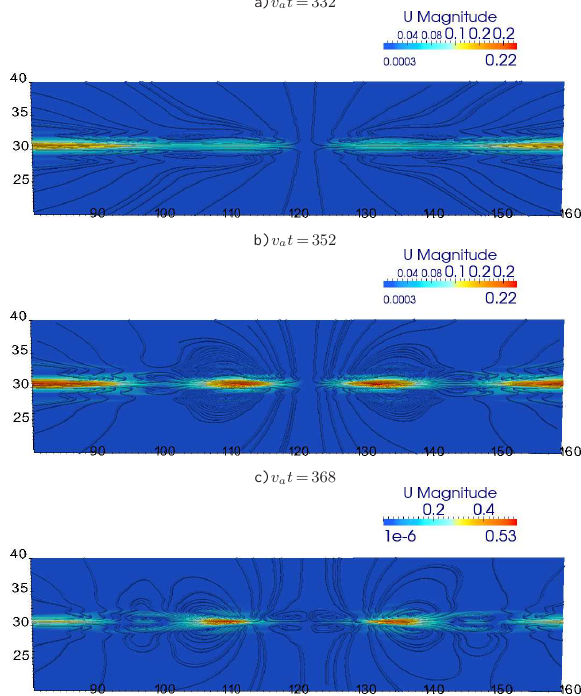
Fig. 6. Later evolution (xz plane). The flow lines are shown super- Fig.6. Later evolution ( x − z plane). The flow lines are shown superimposed over a false colour representation imposed over a false colour representation of the flow speed. The of the flow speed. The SP layer is destabilised by the secondary island instability. Three times are shown. The SP layer is destabilised by the secondary island instability. Three first two have the same color scale, but the third has higher values to avoid saturation. Blow up of the central times are shown. The first two have the same color scale, but the region, the full box is 240x60. third has higher values to avoid saturation. Blow up of the central region, the full box is 240 ×